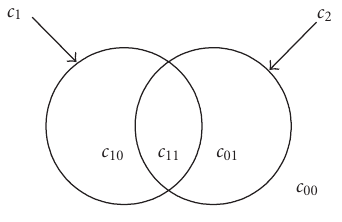
Figure 1: Partitioning of the image into four phases using two curves (average intensity values are designed as c 00 , c 10 , c 01 , c 11